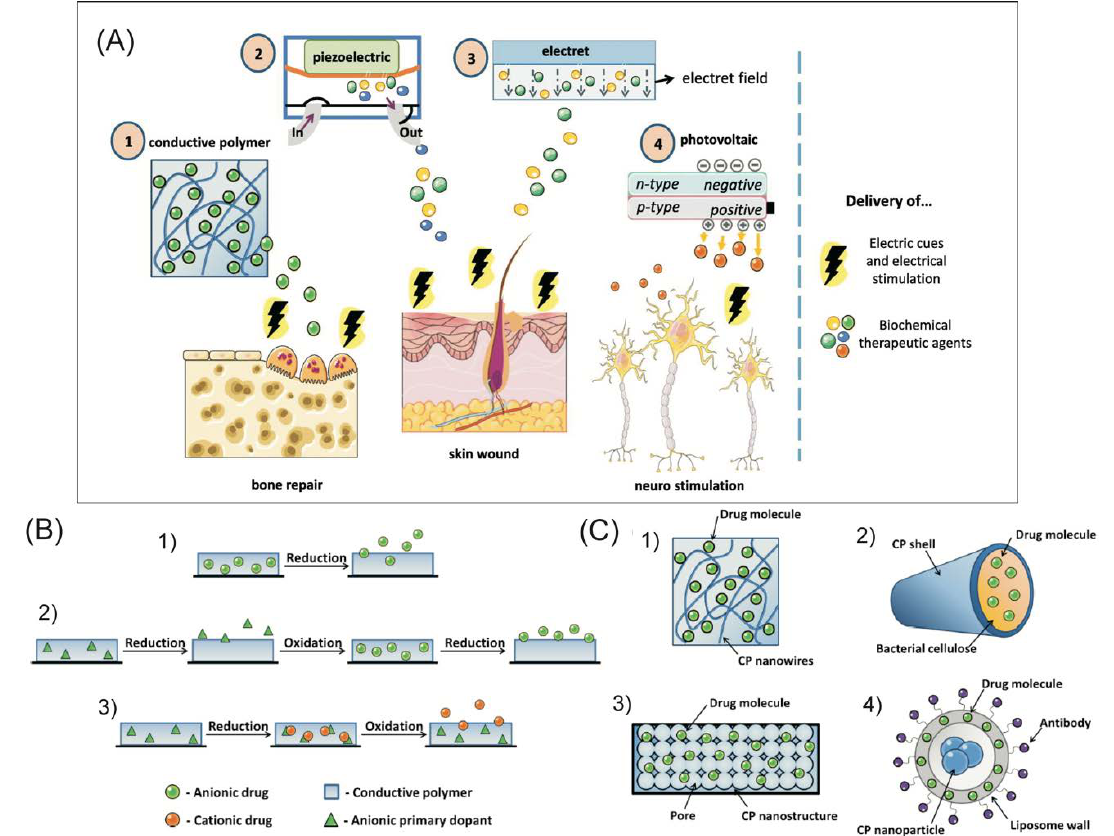
Figure 8. ( A ) Schematic representation of the properties of electroconductive biomaterials and their applications [202]. ( B ) Mechanism of drug loading and release in CPs: (1) one-step loading of anionic drug; (2) three-step loading of anionic drug; and (3) loading of cationic drug [202]. ( C ) Examples of advanced CP-based drug delivery solutions include (1) nanowires, (2) microtubes, (3) nanoporous structures, and (4) nanoparticles [202]. Reprinted with permission from Reference [202]. Copyright 2019 Elsevier.